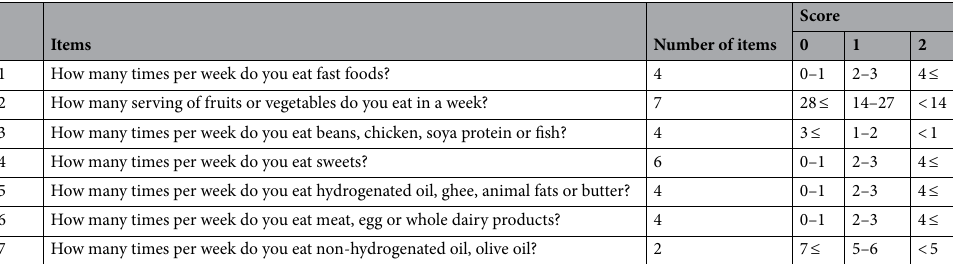
Table 1. Global dietary index